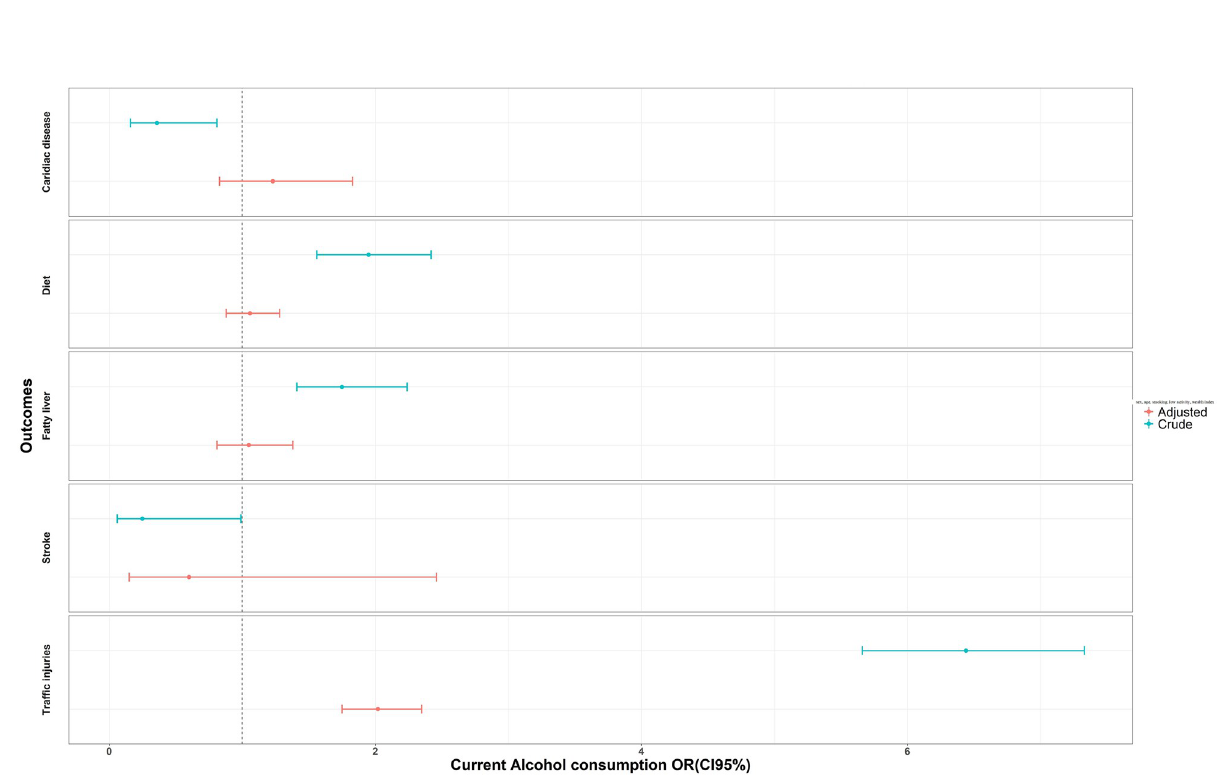
Fig 5. Association of alcohol related disorders with alcohol consumption in logistic regression models: Result from the National Surveillance of Non-Communicable Disease Survey (STEPs).